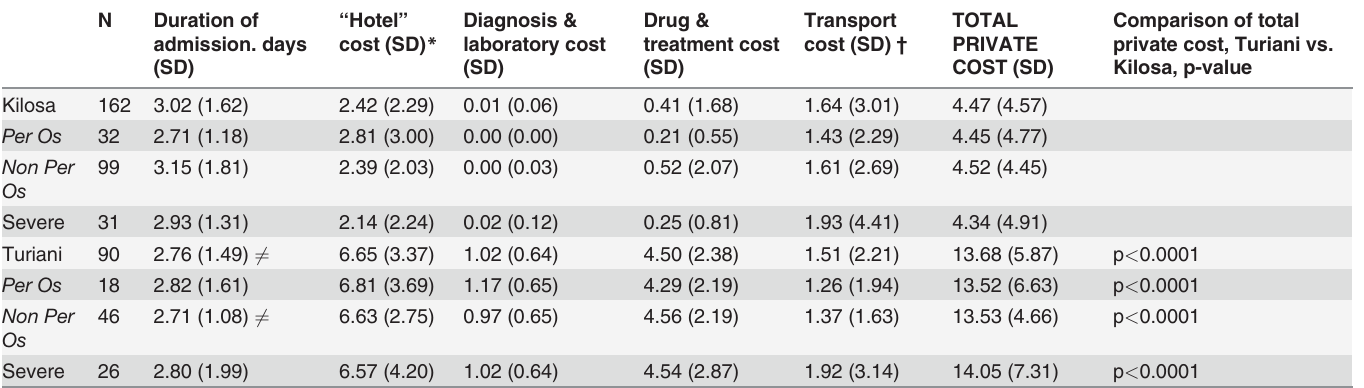
Comparison of total private cost, Turiani vs. Kilosa, p-value